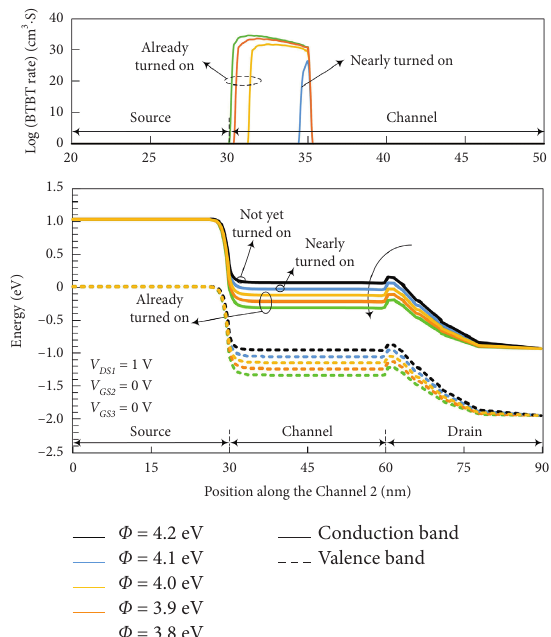
Figure 10: The energy band distribution and BTBTrate of the Ti-TFET with different work functions ( Φ varies from 3.8eV to 4.2eV) in a turn-off